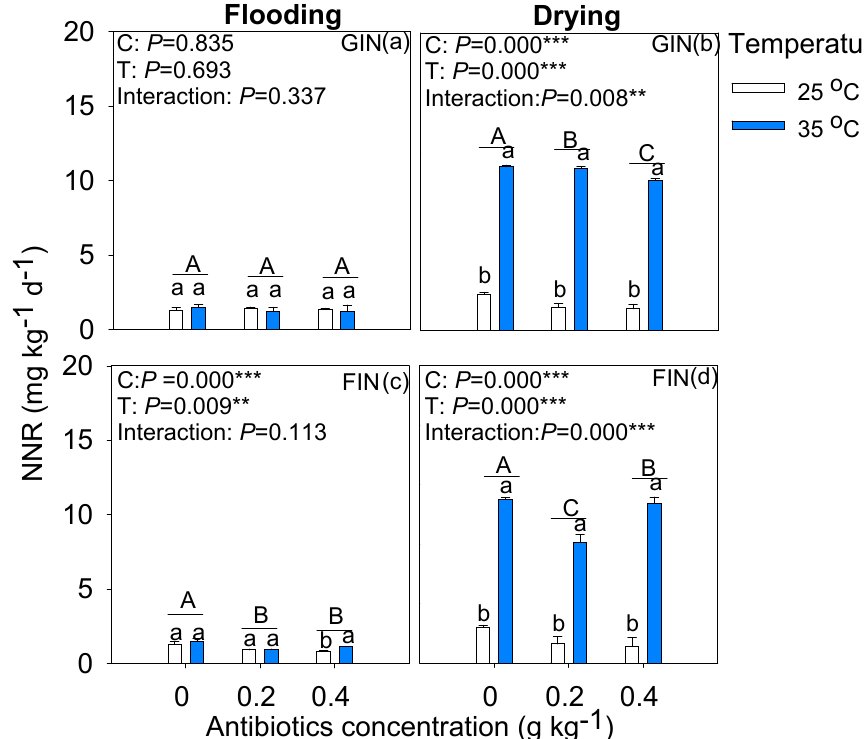
Figure 4. Net nitrification rates (NNR) with the antibiotics content of 0, 0.2 and 0.4 g kg − 1 in the flooding and drying conditions at 25 °C and 35 °C. Different uppercase letters indicate significant differences among antibiotics concentrations of 0, 0.2 and 0.4 g kg − 1 . Different lowercase letters represent significant differences between 25 and 35 °C at the same antibiotic concentration ( p < 0.05). Different numbers of asterisks represent a significant difference (* p < 0.05, ** p < 0.01, *** p < 0.001).